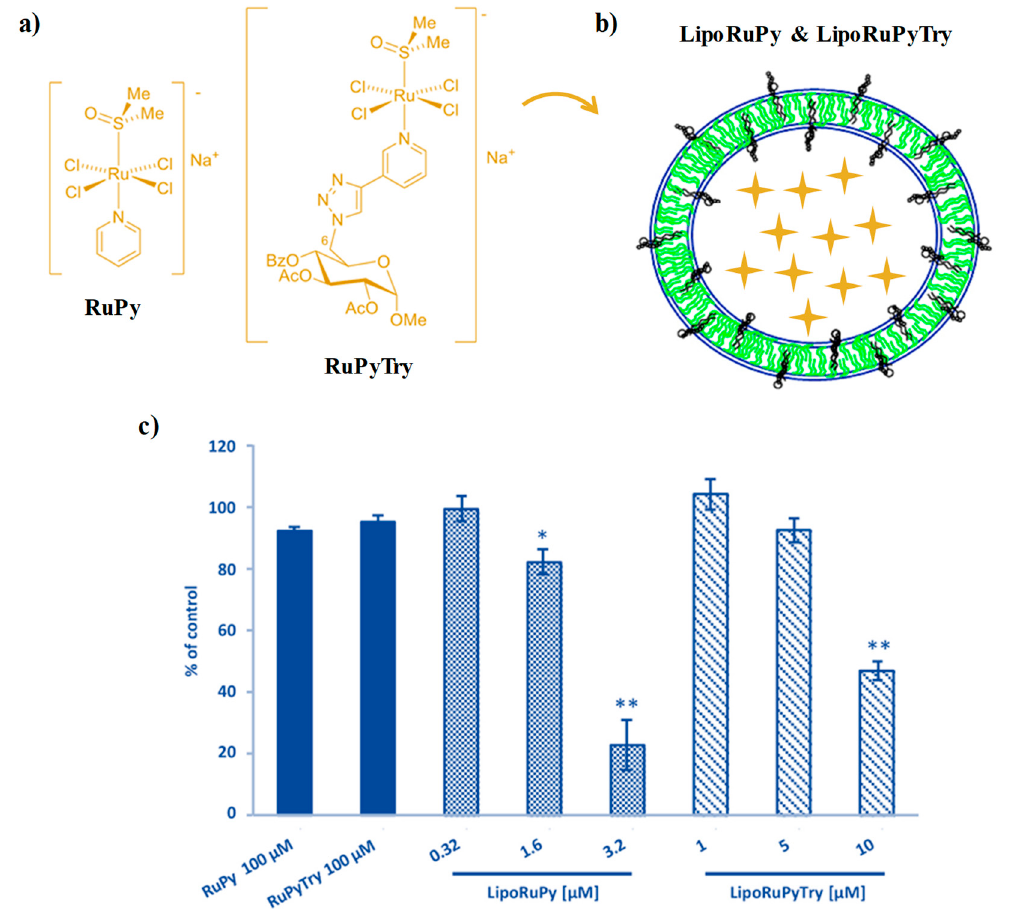
Figure 5. Pyridine-containing Ru(III) complexes inserted in liposome systems: ( a ) chemical structure of the proposed RuPy and RuPyTry compounds; ( b ) schematic representation of liposomal nanoaggregates containing the pyridine-based Ru(III) complexes; ( c ) dose-response histograms reporting the cytotoxic effects observed for the naked Ru(III) compounds and their liposomal formulations in PC-3 cancer cells after 48 h treatment. Figures are adapted from [116].